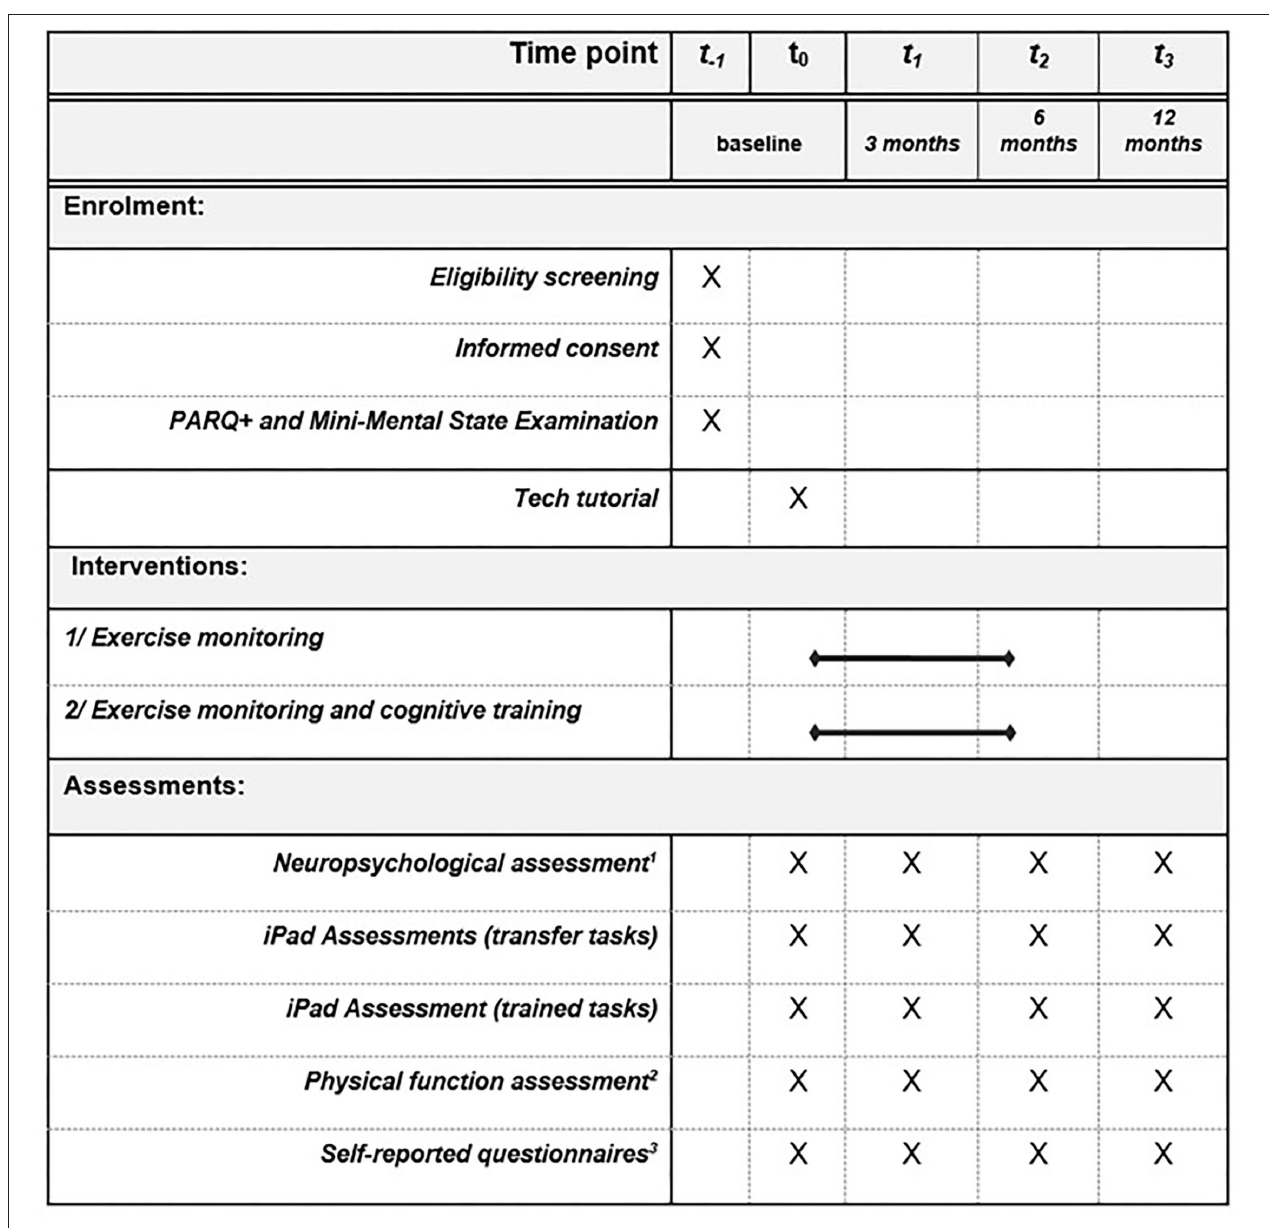
FIGURE 1 | Schedule of enrolment, interventions, and assessments according to SPIRIT guidelines. 1 Montreal Cognitive Assessment, Trail Making Test, Verbal Fluency Test, Digit Span Test, Similarity Test, Rey Auditory Verbal Learning Test. 2 One leg balance test, 5-time Sit to Stand test, Timed up and go test, 4-meter walking speed test. 3 Matthew questionnaire for estimated cardiorespiratory fitness, SF-12, Pittsburgh Sleep Quality Index and Berlin Questionnaire, Short Diet Questionnaire, Stait Trait Anxiety Inventory, Geriatric Depression Scale, Perceived Stress Scale, Perseverative Thinking Questionnaire, Intolerance of Uncertainty